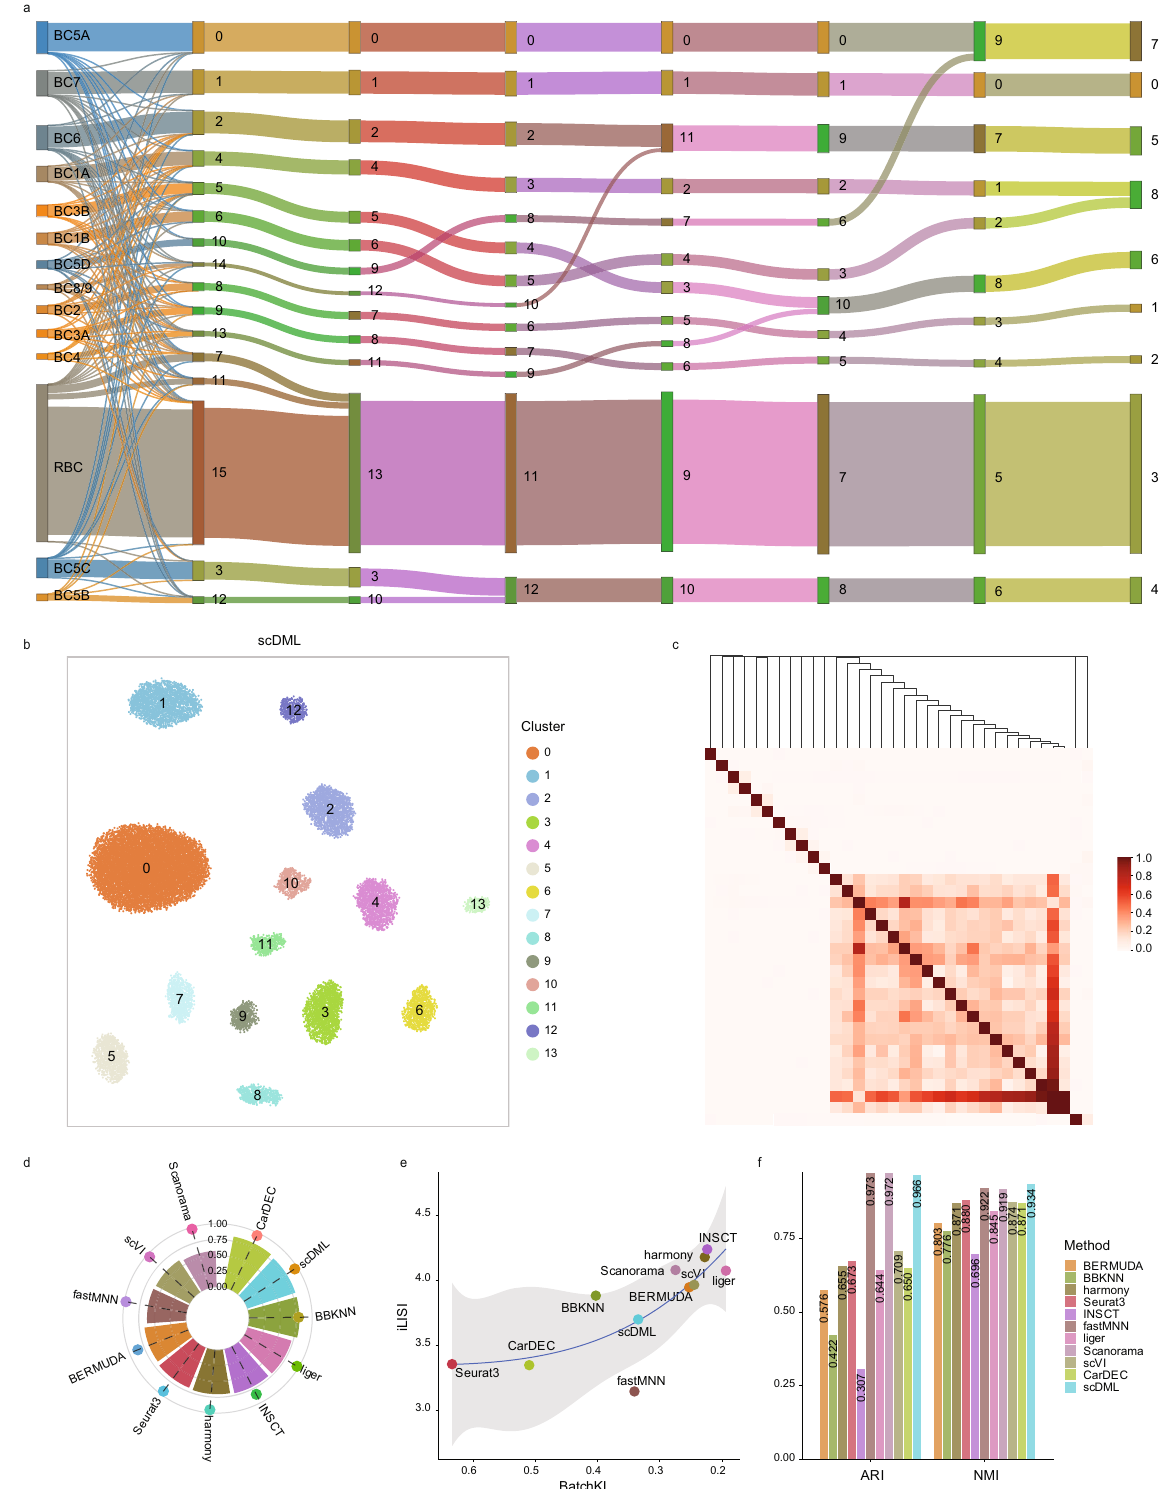
Fig. 7 | scDML preserves the hierarchical structure when merging clusters for the mouse retina dataset. a Sankey plot shows the merge procedure for scDML. Columns from left to right respectively denote true cell type labels, cluster labels when the number of clusters equals 16, 14, 13, 12, 11, 10 and 9. b UMAP embedding computed from scDML, in which the points are colored by cluster label when the number of clusters is set to 14. c Heatmap shows the hierarchical merging order. d BarplotshowsthevalueofASW_celltypeandASW_batch,inwhichthebarheight